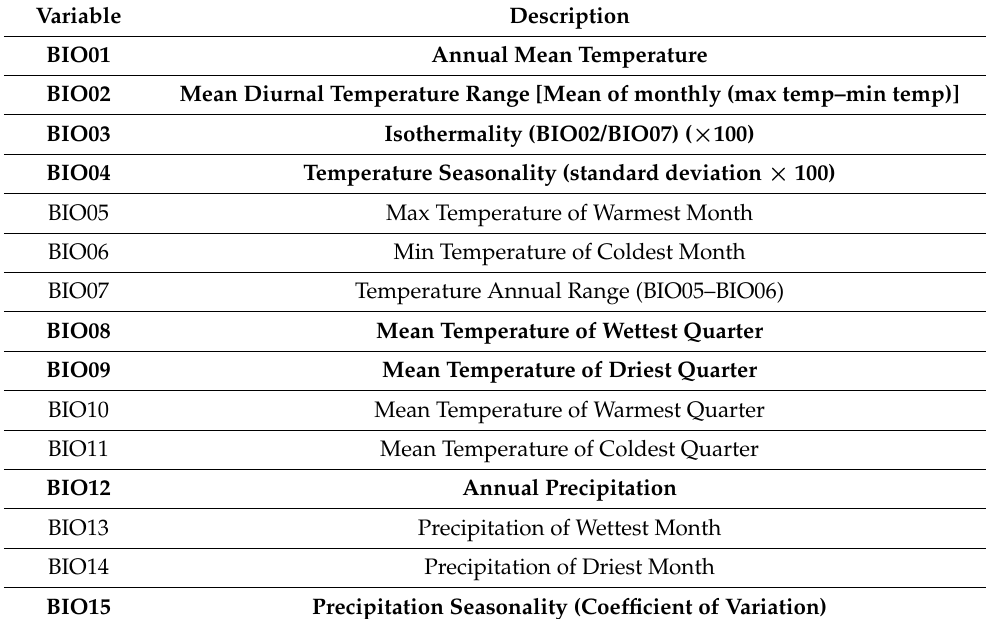
Table 1. List of bioclimatic variables considered for modelling. Variables used in the Species Distribution Models (SDMs) are reported in bold.